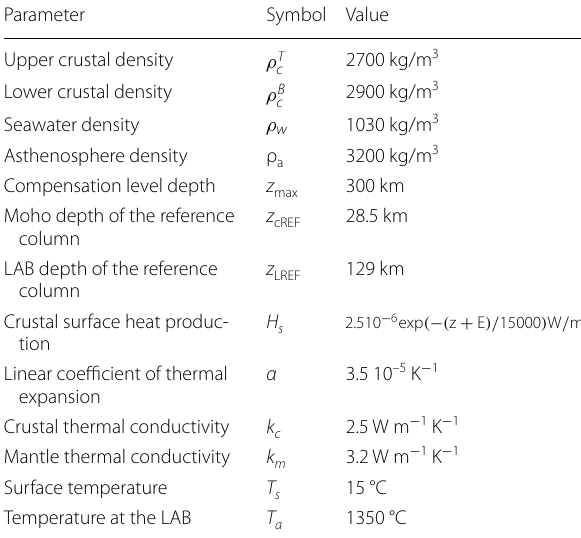
Table 3 Parameters used in the computation of Moho and